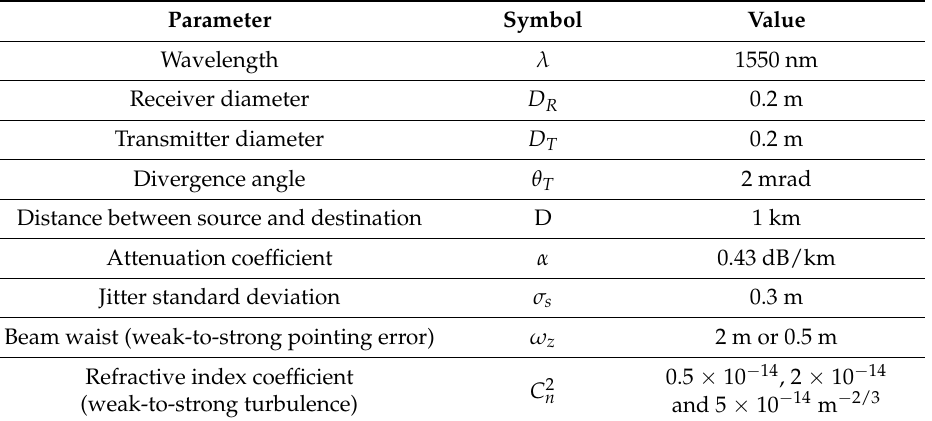
Table 1. SYSTEM Parameters.